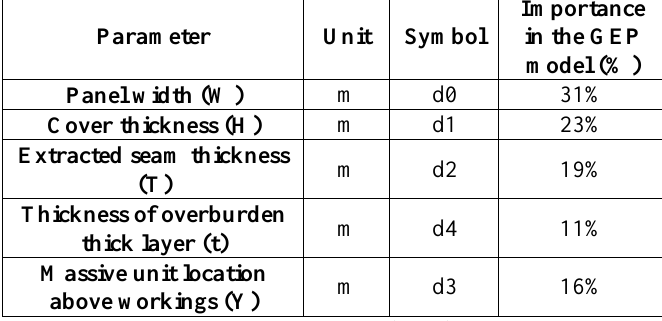
Table 5: Sensivity analysis results of the proposed GEP model.